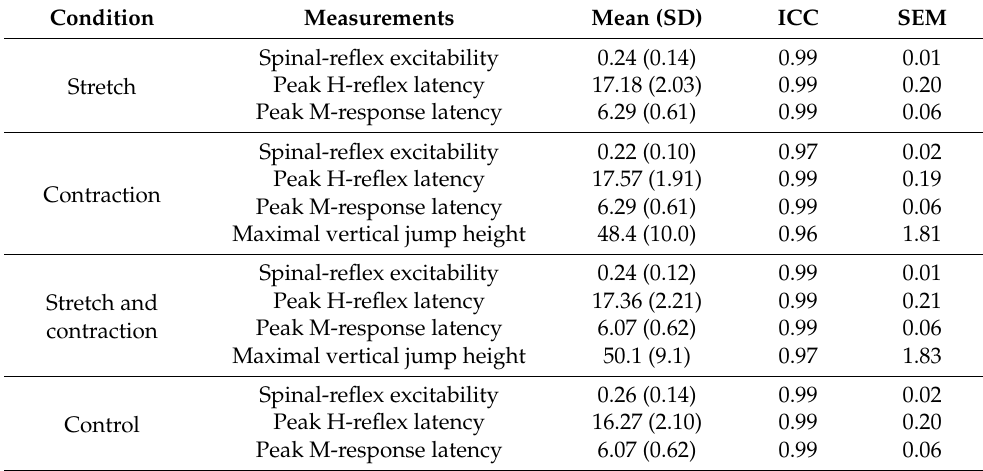
Table 4. Mean (SD), ICC, and SEM of spinal-reflex excitability, H-reflex and M-response latency time, and two-legged countermovement maximal vertical jump height at the pre-condition